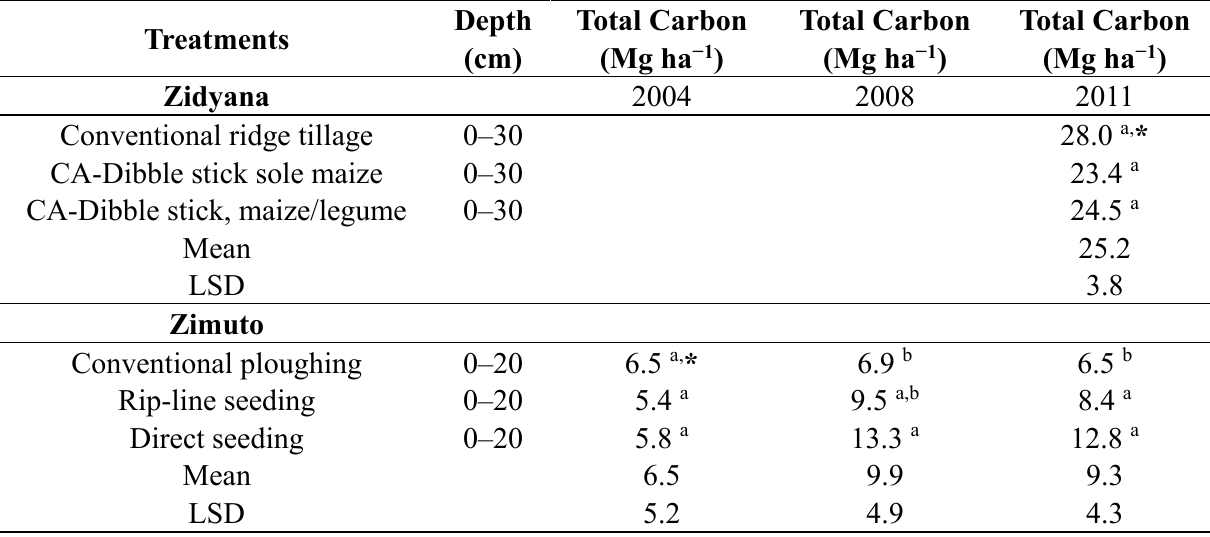
Table 4. Changes in total soil carbon content in 2004 and 2008 (Zimuto) and 2011 (Zidyana) in two conservation agriculture and one conventional